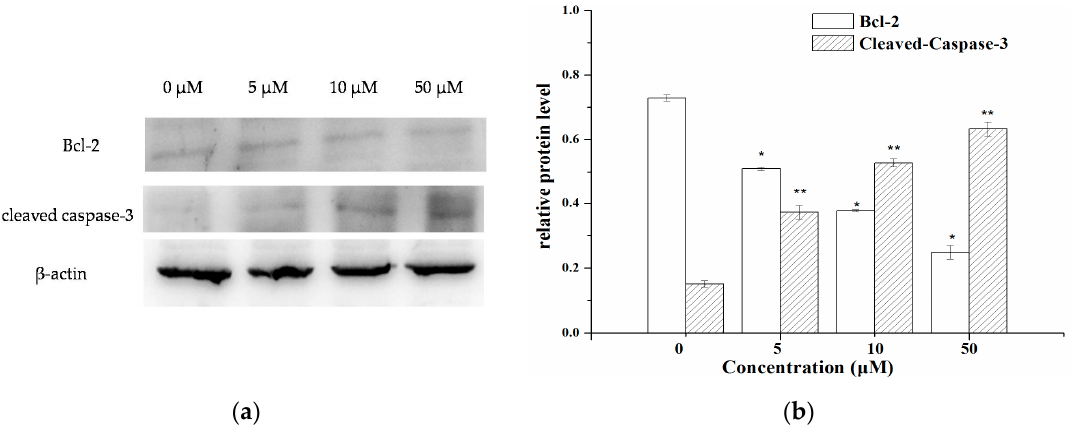
Figure 5. ( a ) The expression of apoptosis-related proteins Bcl-2, caspase-3, and cleaved caspase-3 in MCF-7 cells treated with 0, 5, 10, 50 μ M V 18 ; ( b ) The protein content normalized by β -actin. Apoptosis-related proteins were detected with Western blotting utilizing specific antibodies. * p < 0.05 compared to Bcl-2 of the control group; ** p < 0.05, compared to cleaved caspase-3 of the control group.